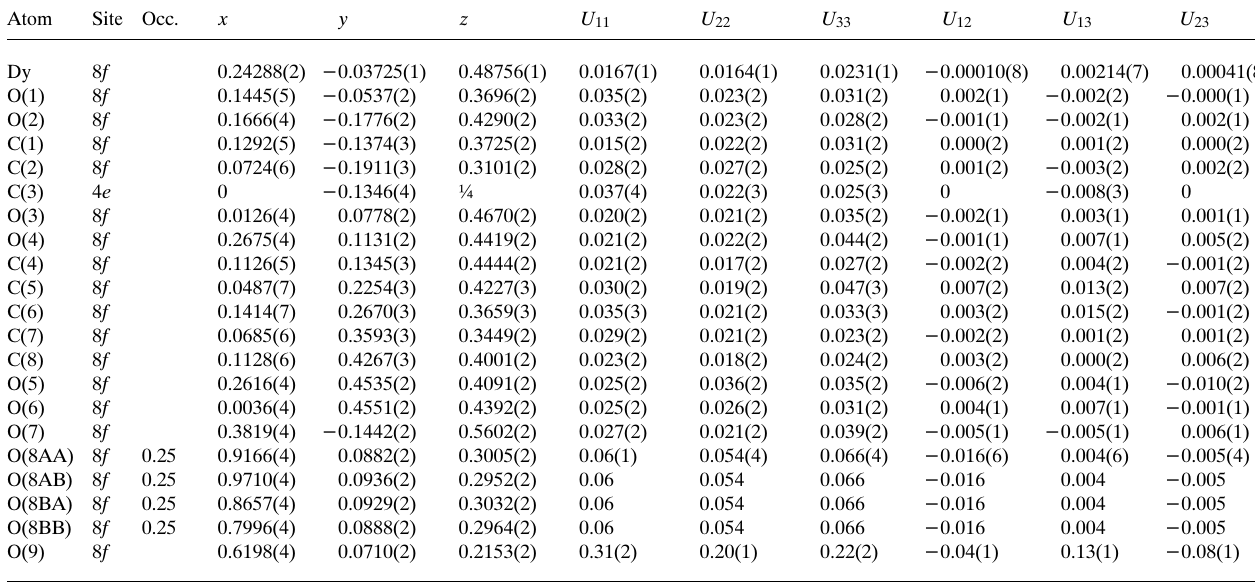
Table 3. Atomic coordinates and displacement parameters (in Å 2 ) .